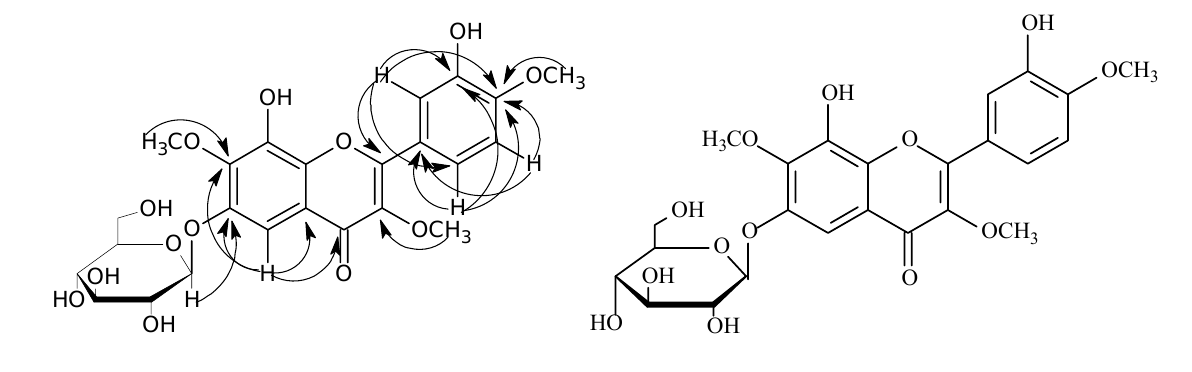
Figure 2. The key HMBC correlations of compound 1